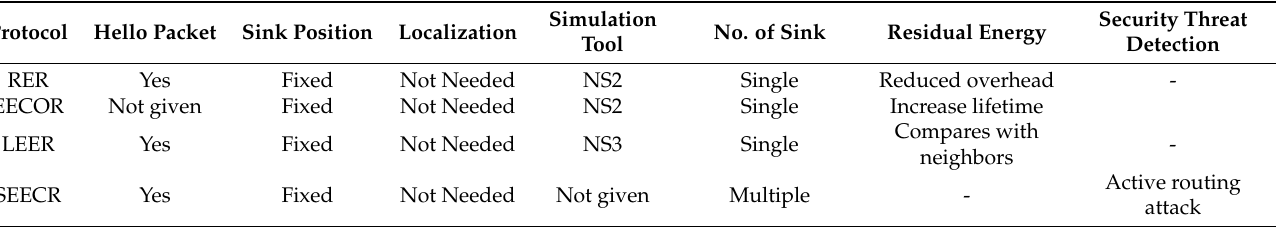
Table 9. Comparison of Cooperative-Reliability-based